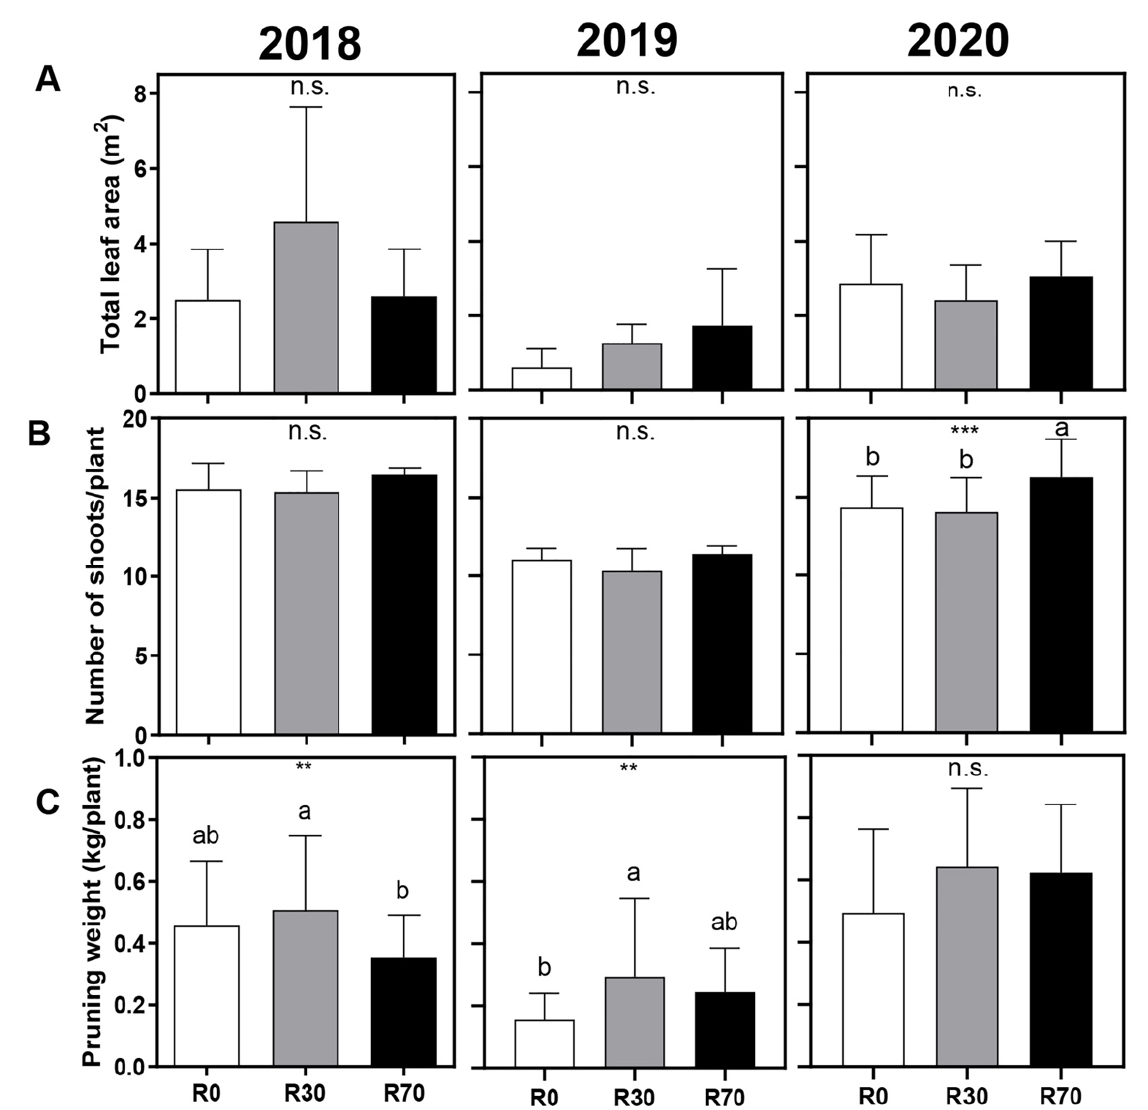
Figure 3. Effect of different irrigation conditions on ( A ) total leaf area at harvest, ( B ) number of shoots per plant, and ( C ) pruning weight at dormancy stage, in 2018, 2019, and 2020 vintages of grape cv. ‘Touriga Nacional’. Irrigation conditions: R0 = non-irrigated plants; R30 = deficit irrigation corresponding to 30% of evapotranspiration; R70 = deficit irrigation corresponding to 70% of evapotranspiration. Results represent mean ± SD of four replicates. Asterisks indicate ANOVA statistical differences: ** p ≤ 0.01; *** p ≤ 0.001; n.s. = non–significant. Lowercase letters indicate differences